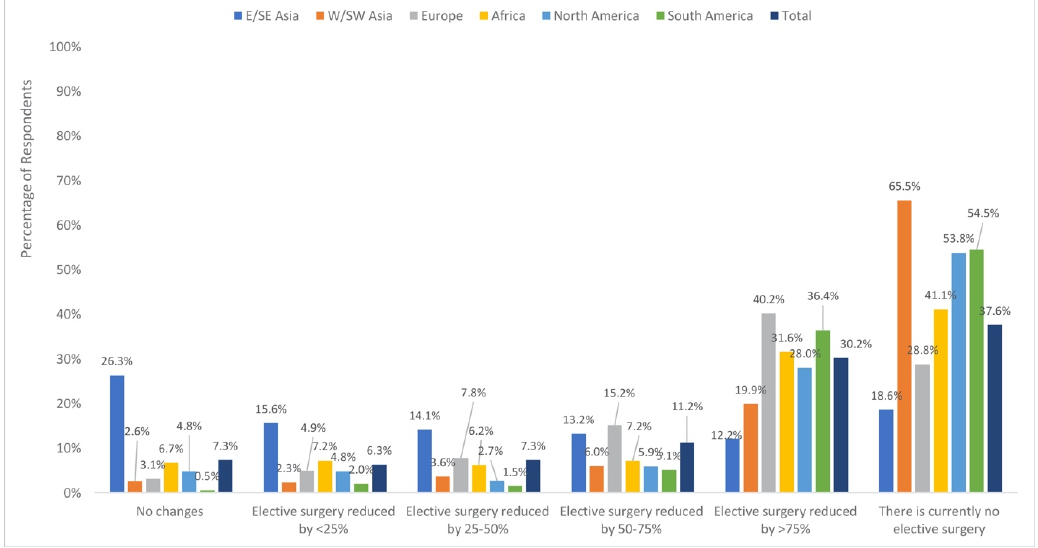
Figure 3. Access to the operating room for elective surgeries by region .